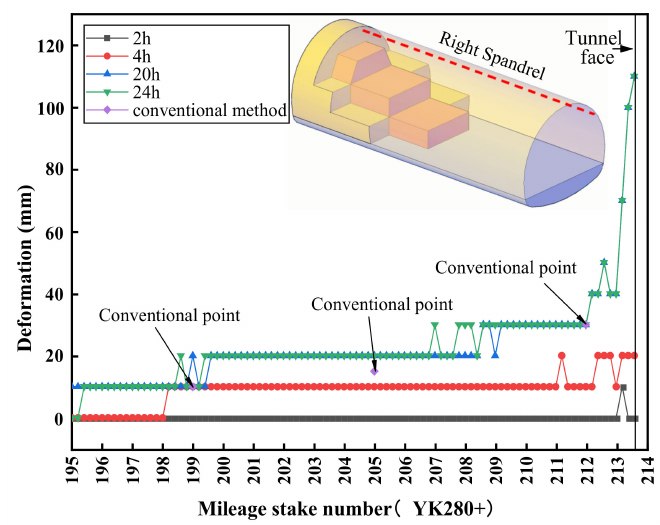
Figure 16. Longitudinal distribution of total deformation of the right spandrel at right line entrance in 24 h.